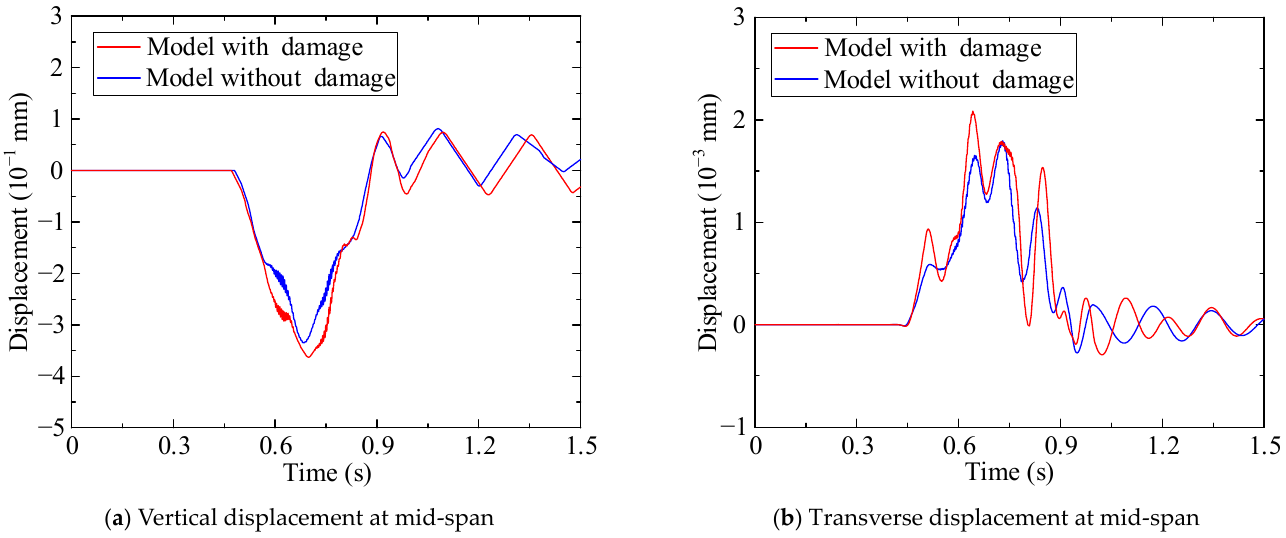
( b ) Transverse displacement at mid-span Figure 25. Responses of the composite beam at a train speed of 300 km/h in the case of T-1.